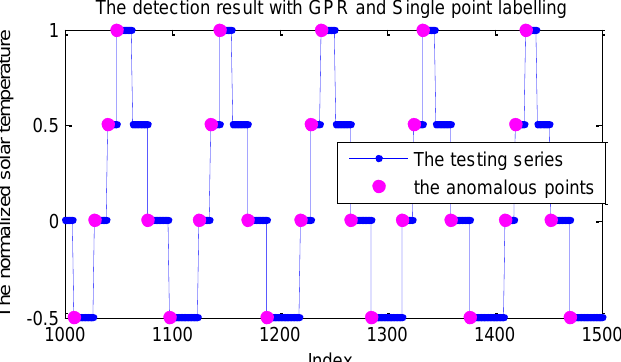
Figure 2. One labelling example for the solar temperature series with the Gaussian process regression (GPR) model.